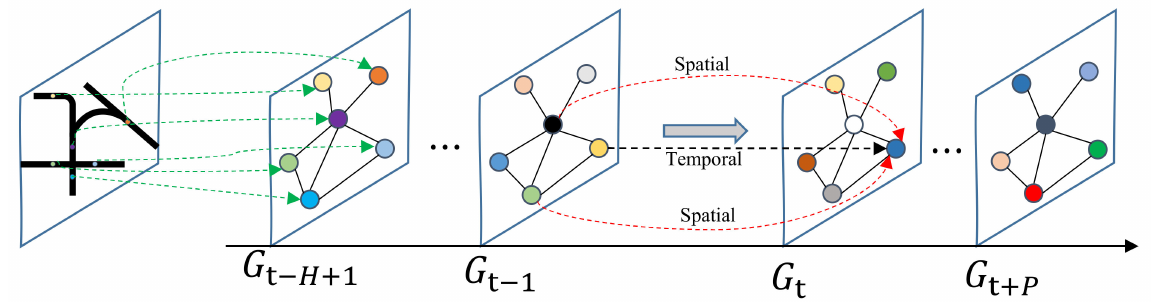
Figure 1. Schematic diagram of the evolution of the spatio-temporal graph prediction of traffic